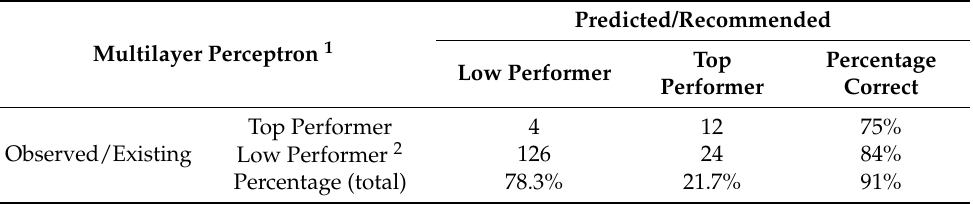
Table 6. Sensitivity and specificity of the Neural Network (Multilayer